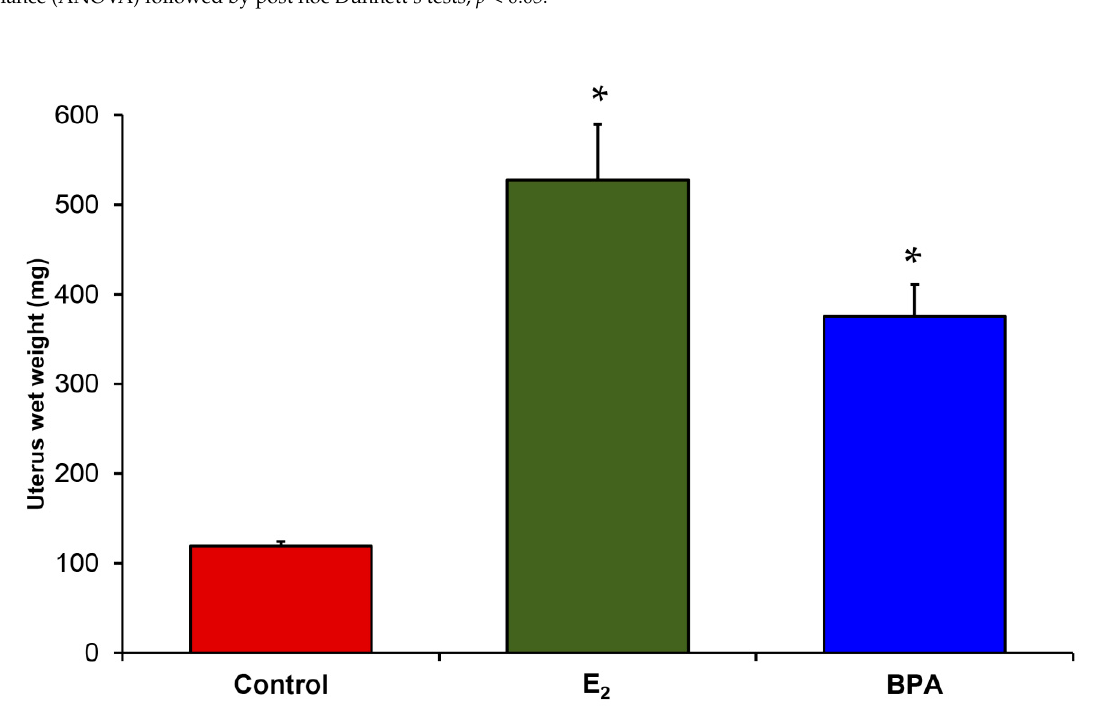
Table 1. E 2 -regulated proteins in OVX rat uterus verified by targeted proteomics and applied to testing BPA [34,53–58] as a well-known estrogenic EDC.